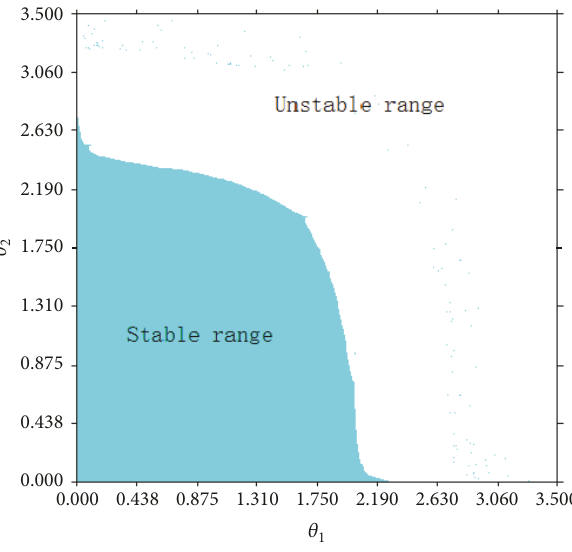
Figure 1: The stable range of system (14).